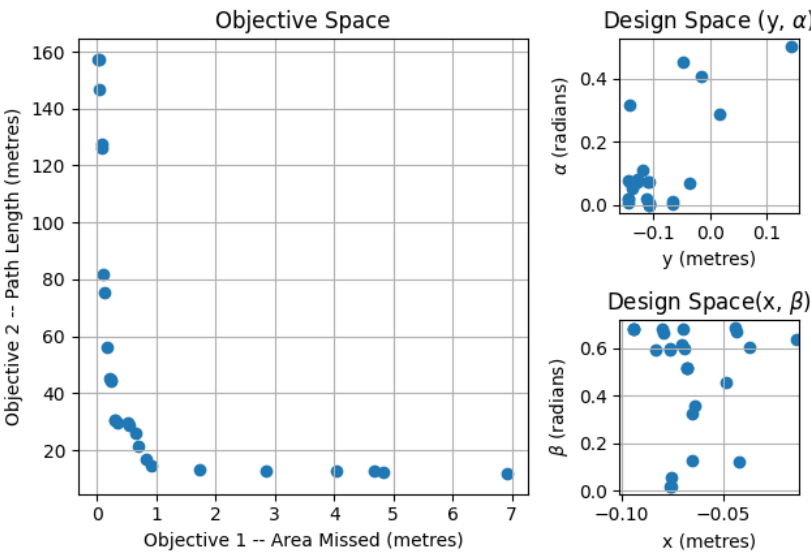
Figure 7. NSGA2 optimization for area size 4 × 2 m with population size = 250.